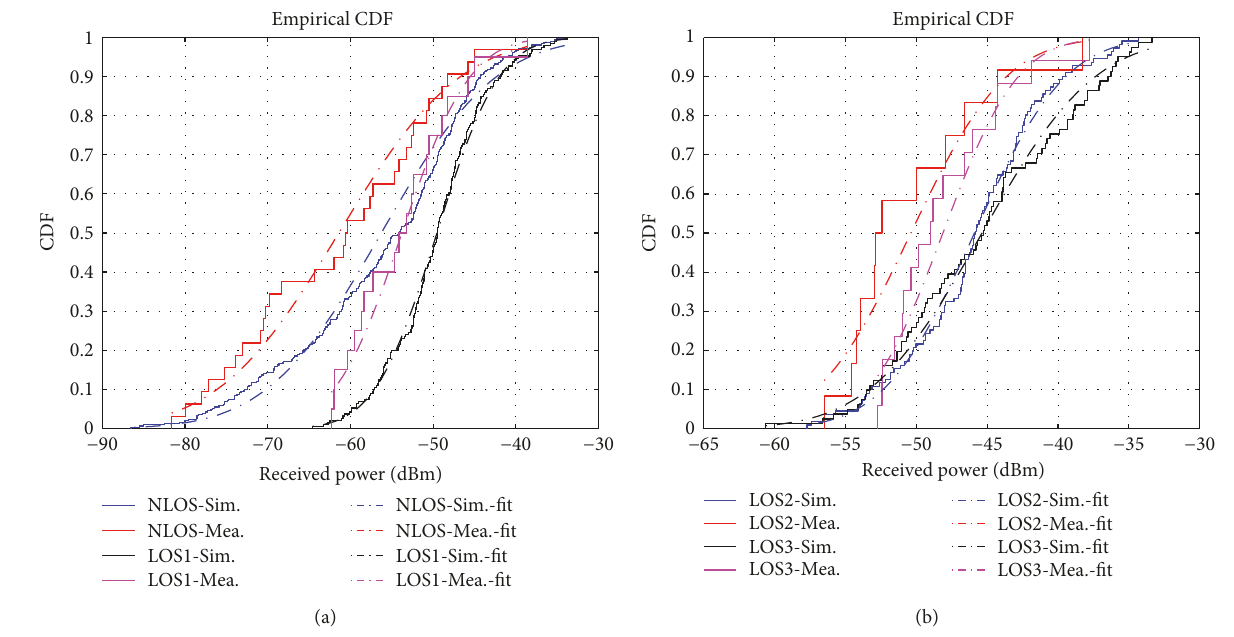
Figure 4: Cumulative distribution function (CDF) of the received power at 6 GHz in LOS and NLOS tunnel scenarios. (a) LOS-1 and NLOS paths and (b) LOS-2 and LOS-3 paths.